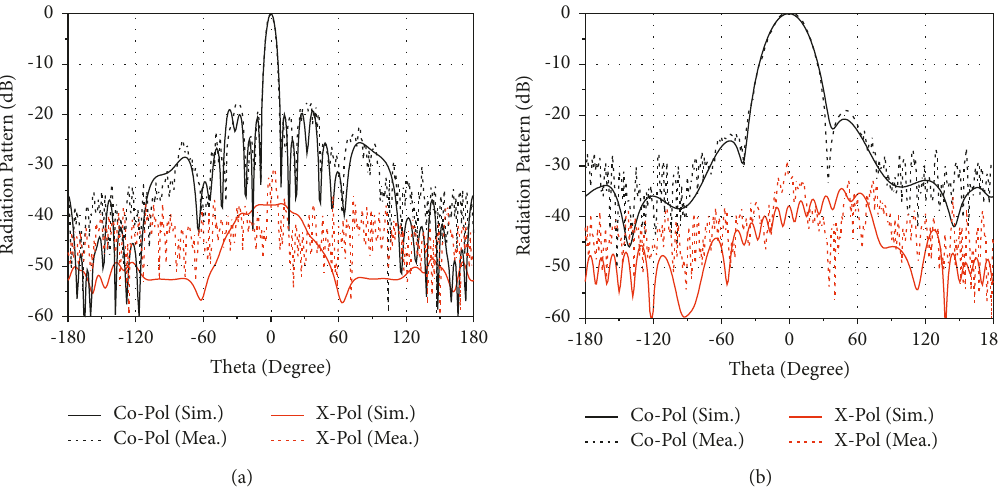
Figure 17: Simulated radiation patterns at 26.9GHz (solid line) and measured one at 27.3GHz (dash line) of the proposed 1 × 4 antenna array. (a) E-plane ( xoz ). (b) H-plane ( yoz